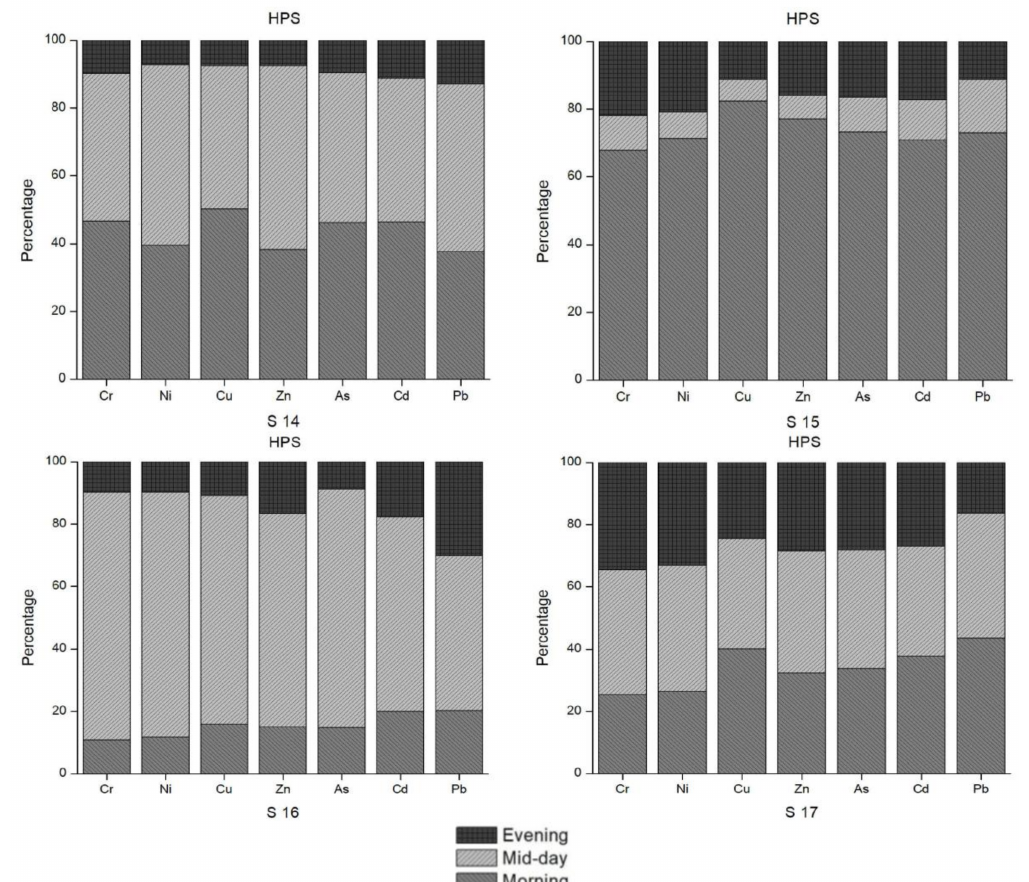
Figure 6. Diurnal trends in heavy metal concentration for selected sample